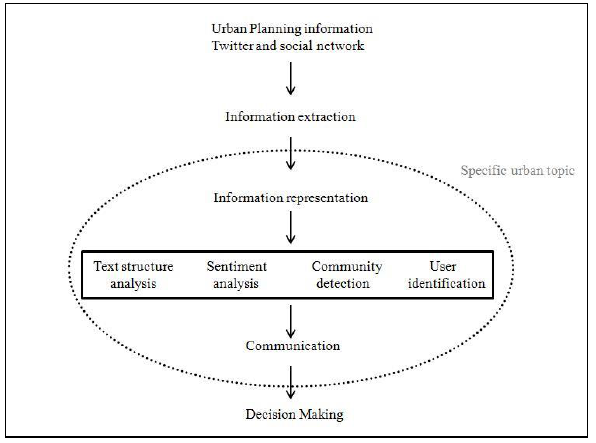
Figure 1. Proposed design